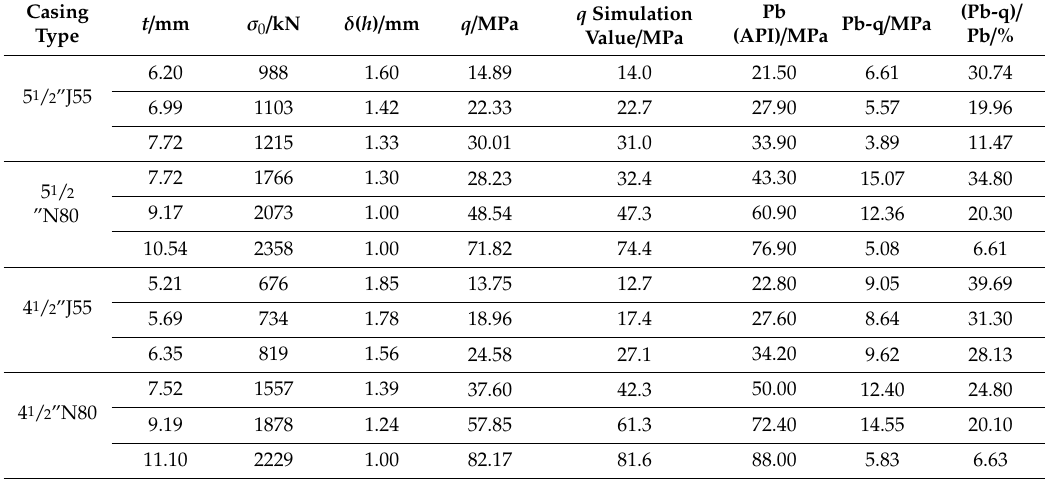
Table 1. Results of local radial load for casings with di ff erent wall